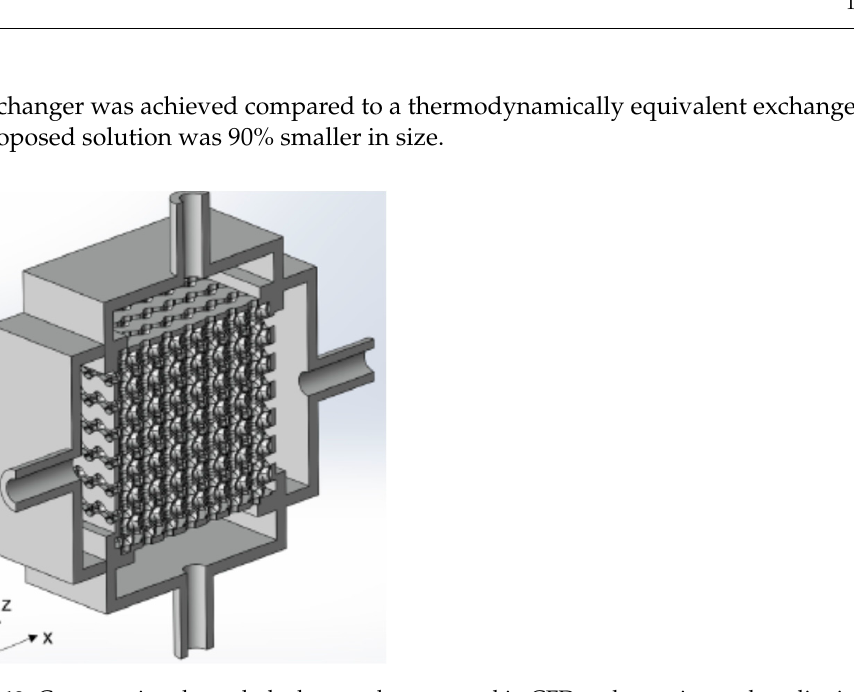
Figure 12. Cross-section through the heat exchanger used in CFD and experimental studies in work of [48].